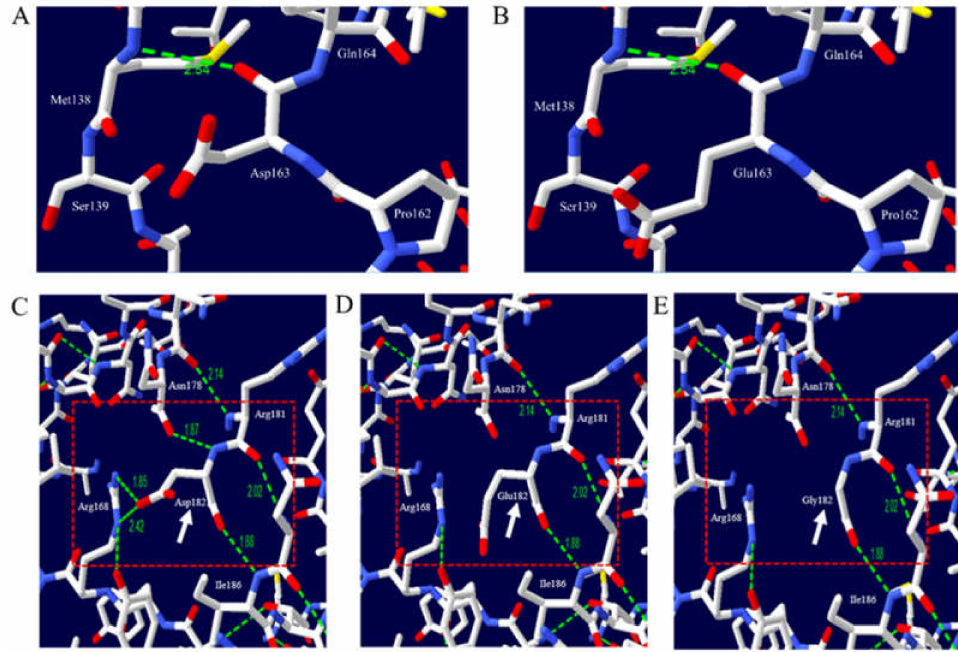
Figure 6. Prediction of 3D structure and hydrogen bonds of dog prion protein (PrP). The white arrow indicates target amino acid residues. The red box indicates adjacent amino acid residues. The green dotted line indicates hydrogen bonds. The green numbers indicate the distance of the hydrogen bonds. ( A ) 3D structure of dog PrP with allele Asp163, ( B ) 3D structure of dog PrP with allele Glu163, ( C ) 3D structure of dog PrP with allele Asp182, ( D ) 3D structure of dog PrP with allele Glu182, and ( E ) 3D structure of dog PrP with allele Gly182.